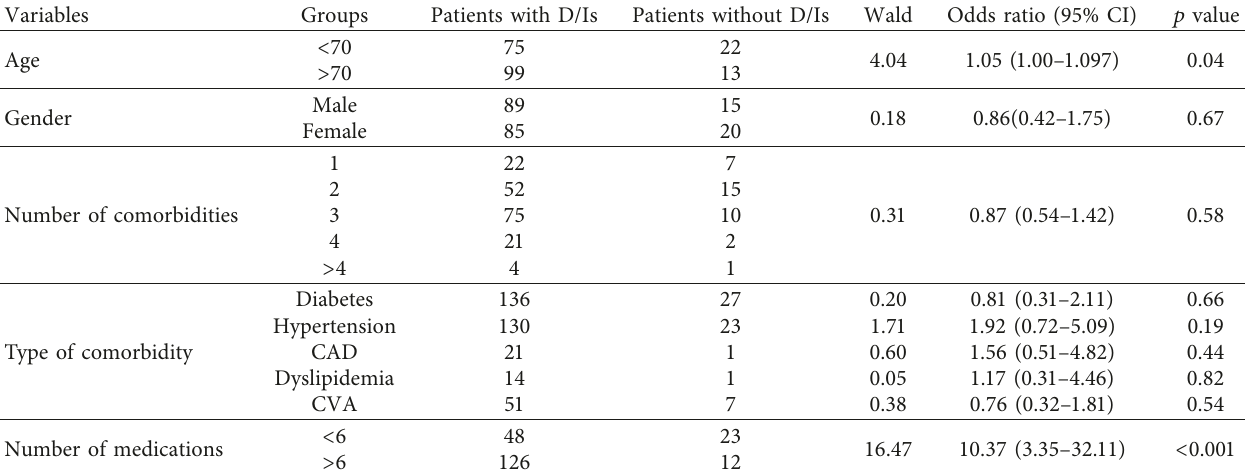
Table 5: Predictors of D/Is (multivariate logistic regression